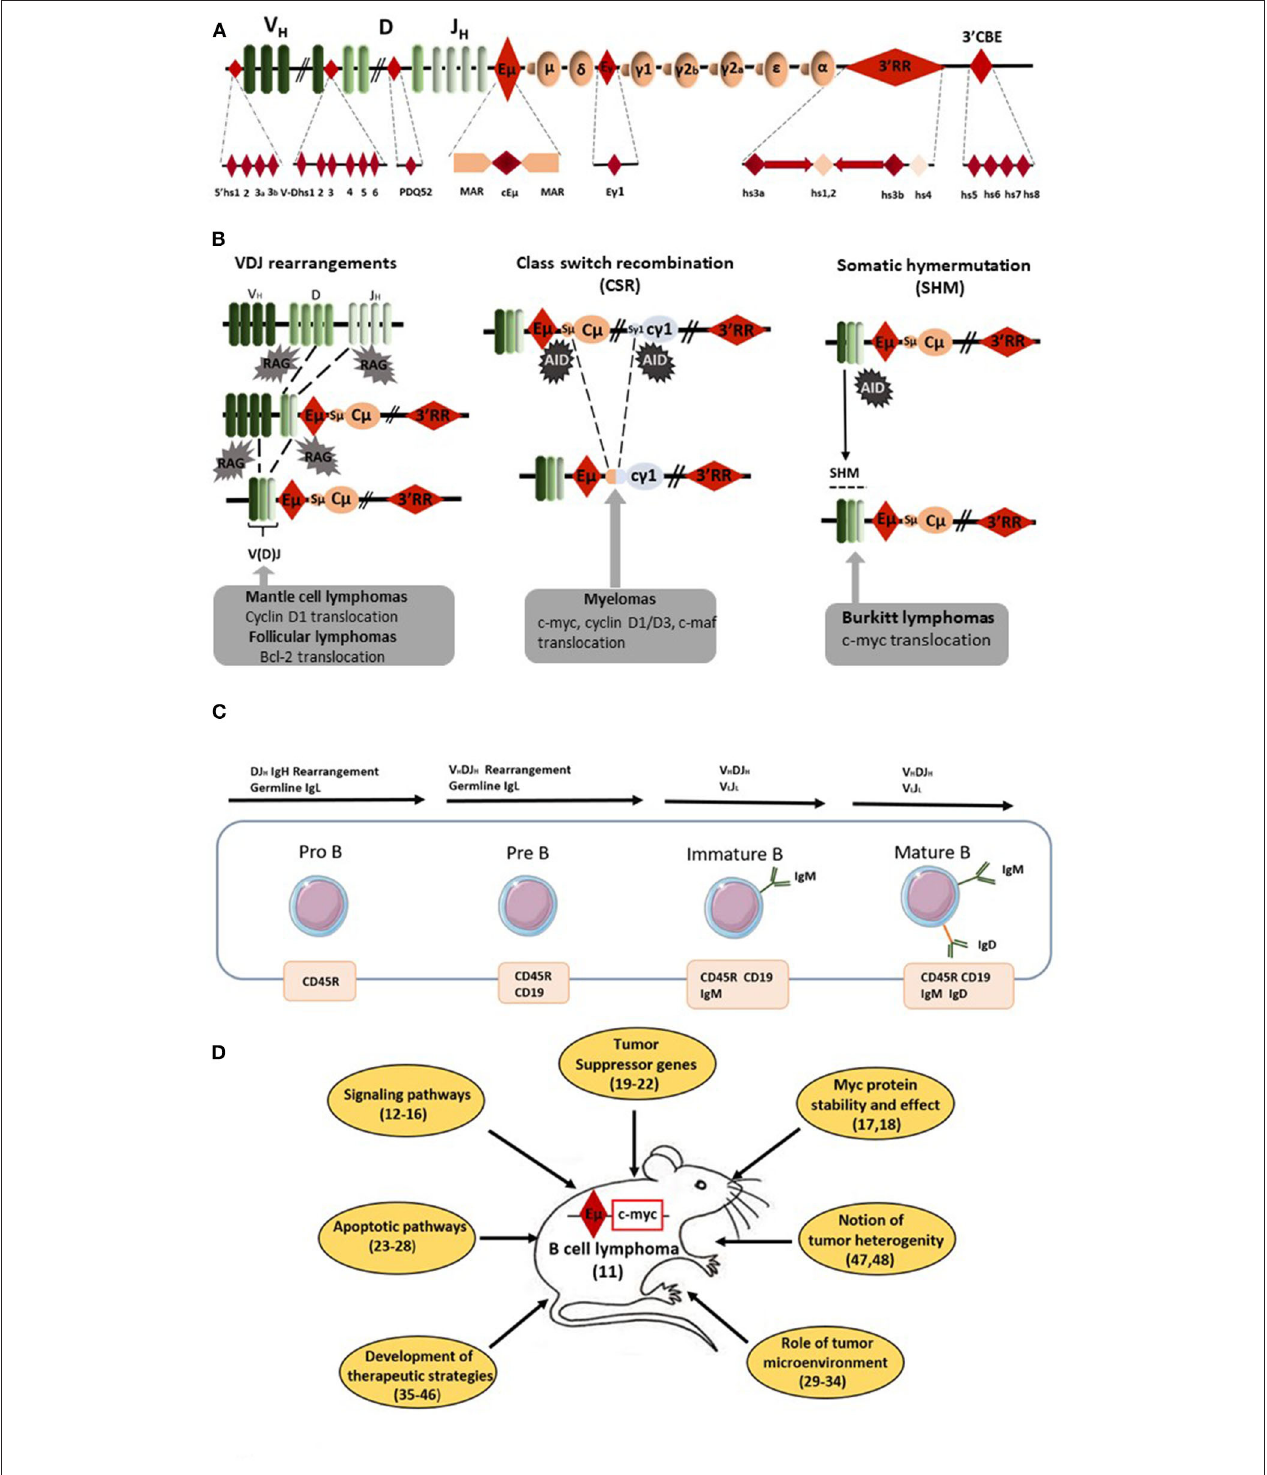
FIGURE 1 | E µ - Myc mice as a model of B-cell lymphomagenesis. (A) Schematic diagrams of the mouse IgH locus. Locations of the various IgH cis -regulatory elements with enhancer or insulator activity are reported: four hs sites located 5’ of the first V segments, six hs sites in the V–D intergenic region, the DQ52